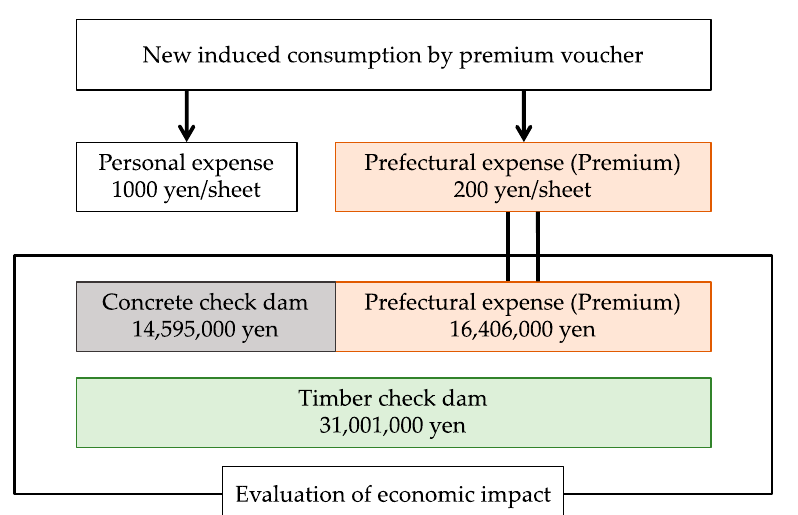
Figure 3. A framework for unifying and comparing the functions and costs of timber and concrete dams. It initially costs 16,406,000 yen more to build a timber dam than a concrete one; the differ- ence can be used to add premiums of 200 yen each to government-issued 1000-yen vouchers for regional development.